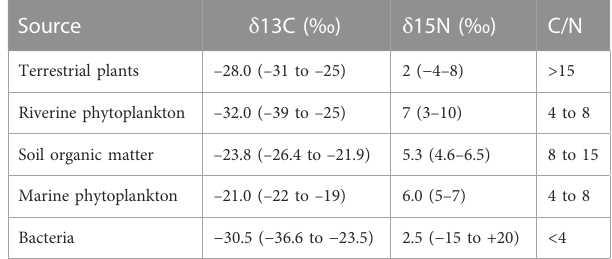
TABLE1Meanandrangeofthe δ 13C, δ 15N,andC/Nratiosofpotential organic matter sources used by MixSIAR analyses and the scatter plot of δ 13C vs C/N ratios and δ 15N vs C/N